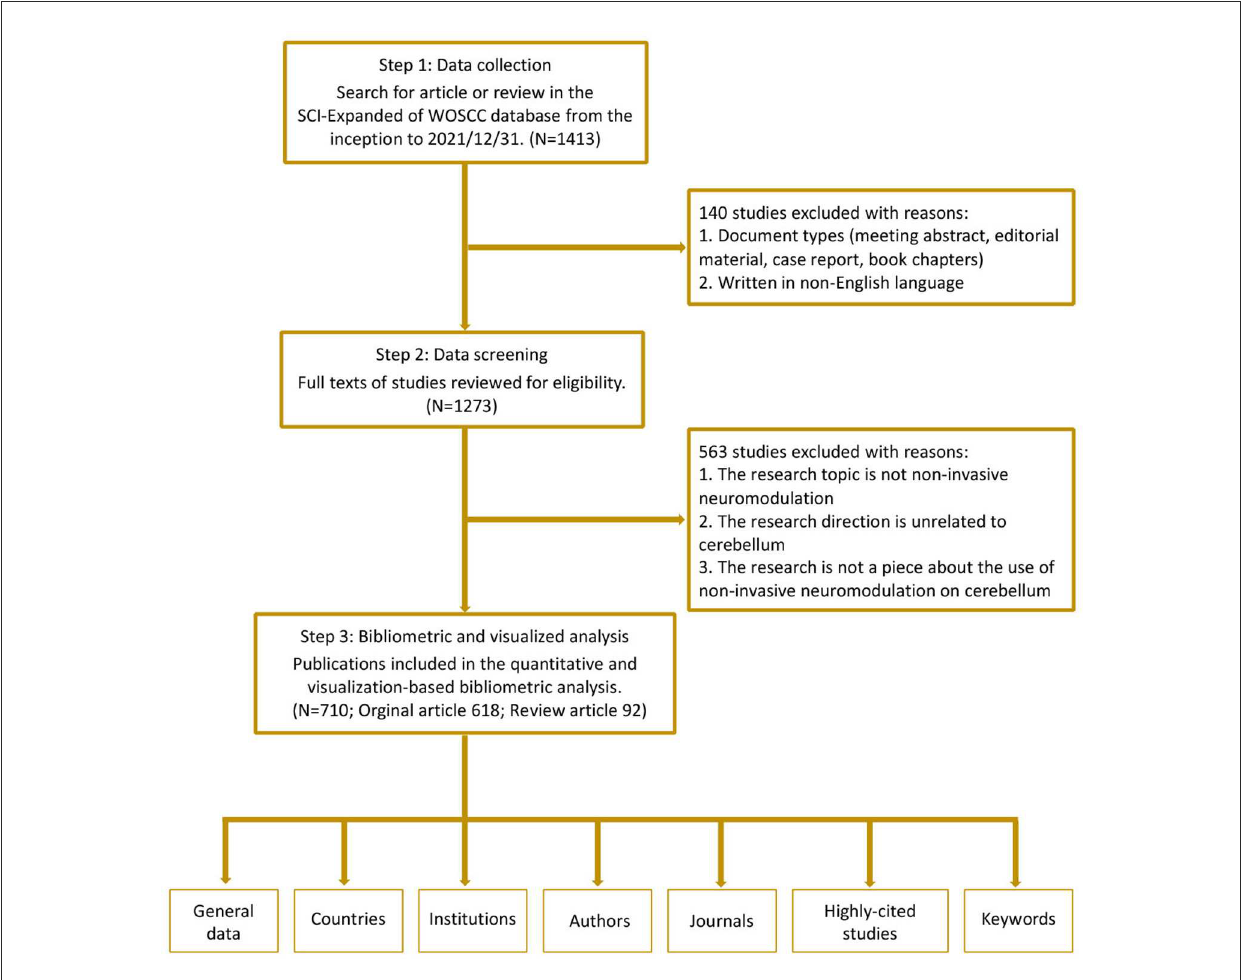
FIGURE1 Flow chart of the bibliometric search and NICS